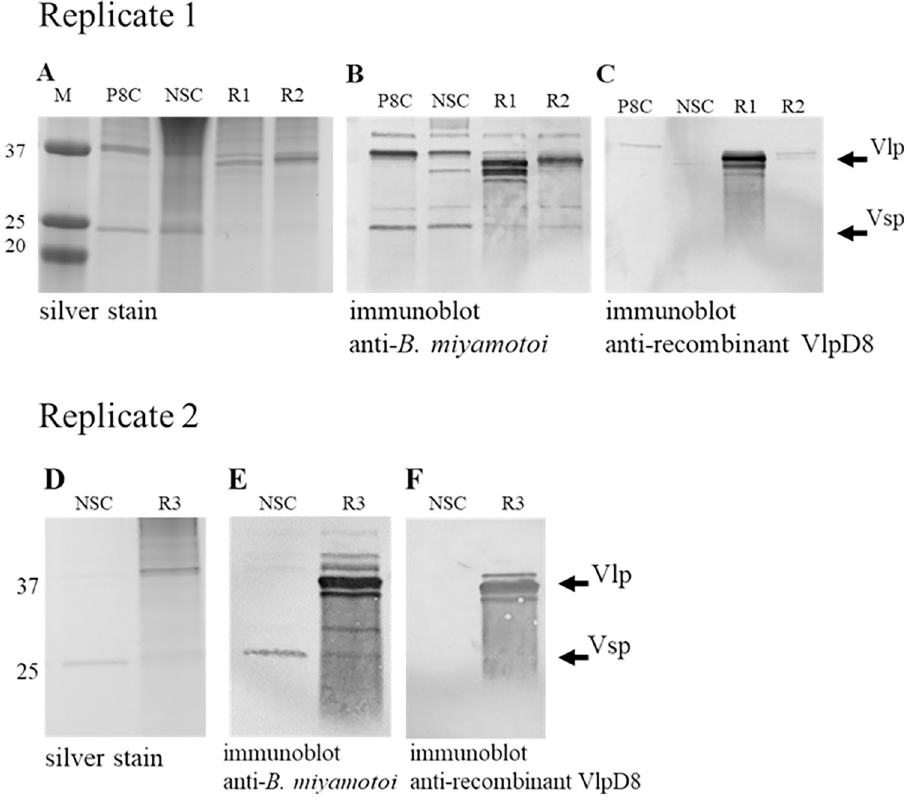
Fig 6. Vmp parent and reisolate comparisons by SDS-PAGE and immunoblot. A) Replicate 1 SDS-PAGE silver stained; B) Replicate 1 immunoblot with mouse anti- B . miyamotoi antiserum; C) Replicate 1 immunoblot with mouse anti-recombinant VlpD8 antiserum; D) Replicate 2 SDS-PAGE silver stained; E) Replicate 2 immunoblot with mouse anti- B . miyamotoi antiserum; F) Replicate 2 immunoblot with mouse anti-recombinant VlpD8 antiserum. P8C = passage 8 parent stock culture control; NSC = parent culture control incubated with no serum; R1 = reisolate 1; R2 = reisolate 2; R3 = reisolate 3. M = molecular size markers that are denoted left and right of the panels in kDa. Arrows on the right of the panels designate molecular migration for Vlp and Vsp